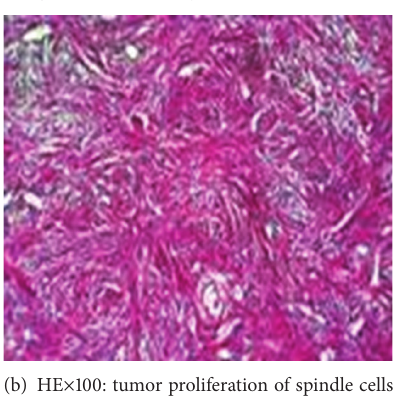
Figure 3: Macroscopic view of the masses.